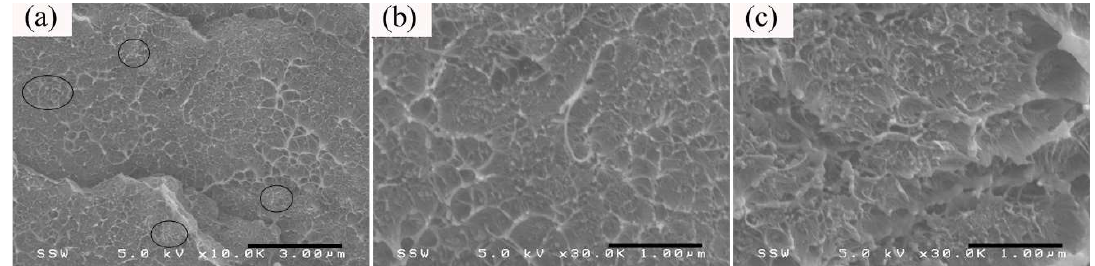
Figure 7. The morphology (TD) taken from the ( a , b ) core and ( c ) shear layers of the thick section of 5 wt %-PS/CNT50/CB50 microparts before the annealing treatment.